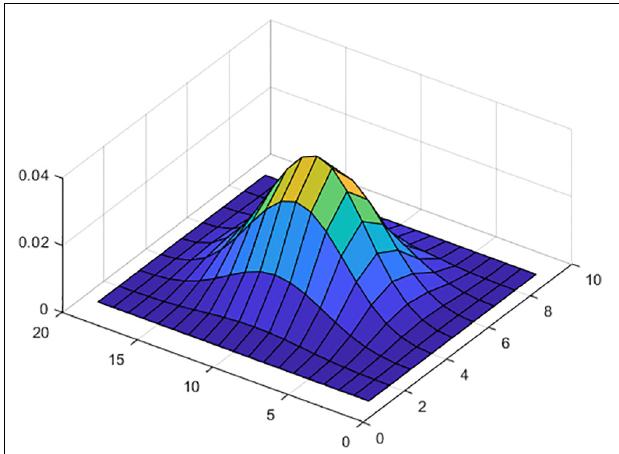
FIGURE 1 | Filter